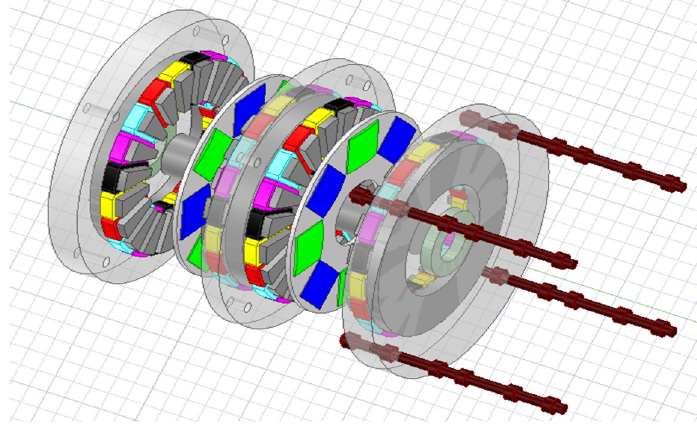
Figure 24. Exploded geometry of the proposed generator.